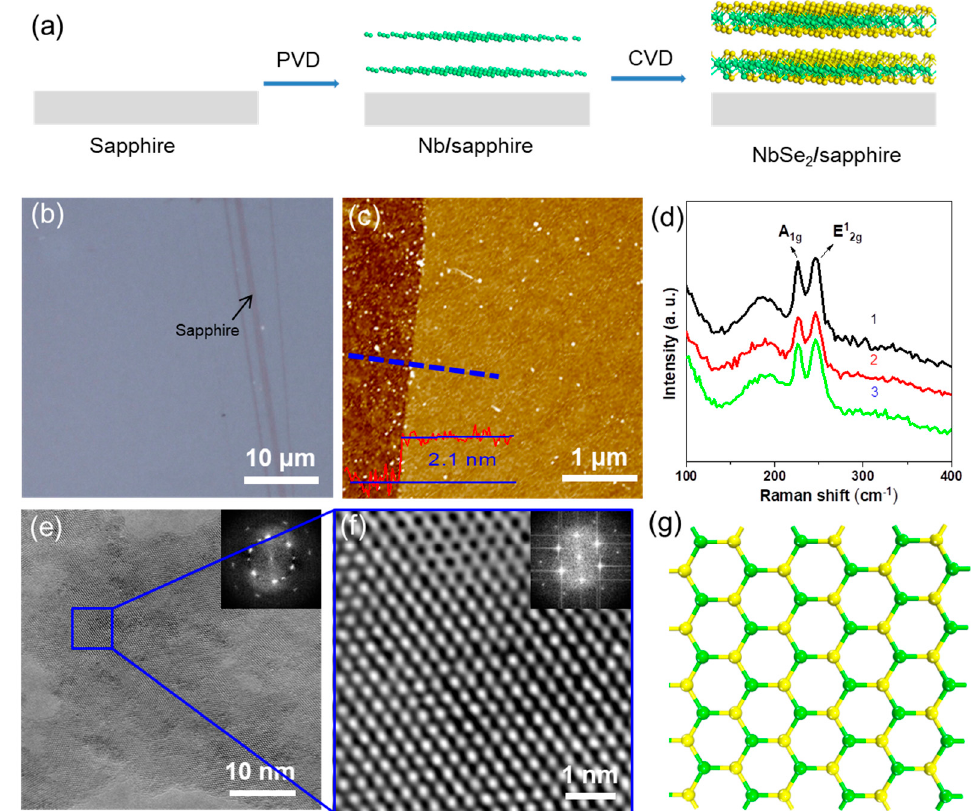
Figure 1. ( a ) A schematic illustration of the two-step vapor deposition method to grow 2D NbSe 2 ; ( b ) optical microscopic image; ( c ) AFM image and the corresponding height profile; ( d ) Raman spectra (3 different sites of the as-grown NbSe 2 were tested and represented as black, red and green lines, respectively) of as-grown NbSe 2 film, the blue dotted line and red line are the measure site and corresponding height profiles, respectively; ( e ) a low-magnification TEM image showing the polycrystalline structure of NbSe 2 film; and ( f ) the atomic structure image of the area marked out by a blue square in ( e ) shows a perfect single-crystalline structure (as confirmed by the inset fast Fourier transform pattern); ( g ) atomic model of NbSe 2 (top view). The green sphere represents the Nb atom and the yellow sphere represents the Se atom.